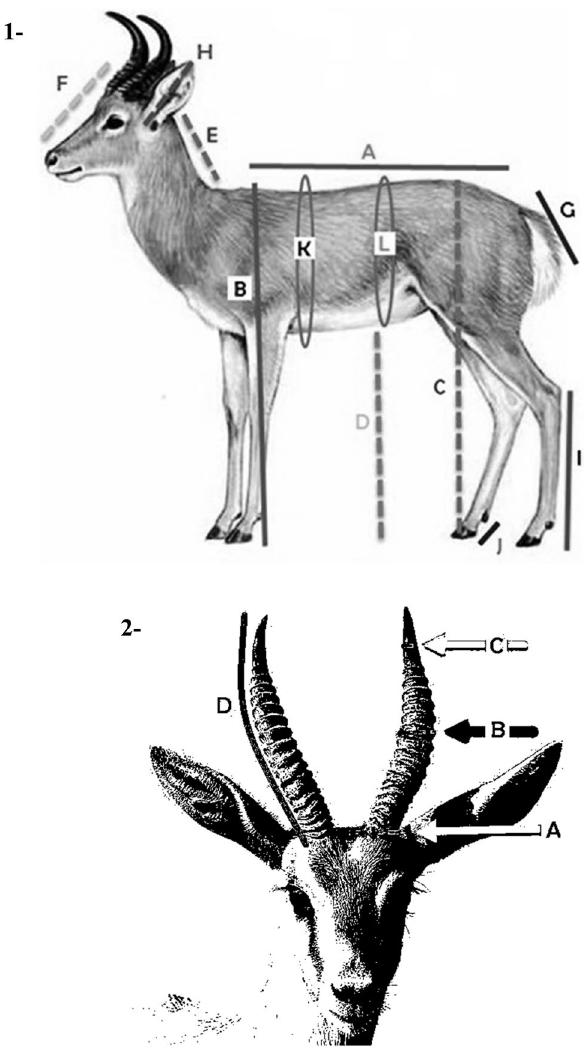
Figure 1. Animal body and horn measurements. 1. Body length (A), Head length (F), Neck length (E), Ear length (H) Tail length (G), Chest girth (K) Belly girth (L), Chest height (B), Pelvic height (C), Hind leg length (I), Belly height (D)and Hock joint height (J). 2. Horn length (D), Horn thickness (A, B and